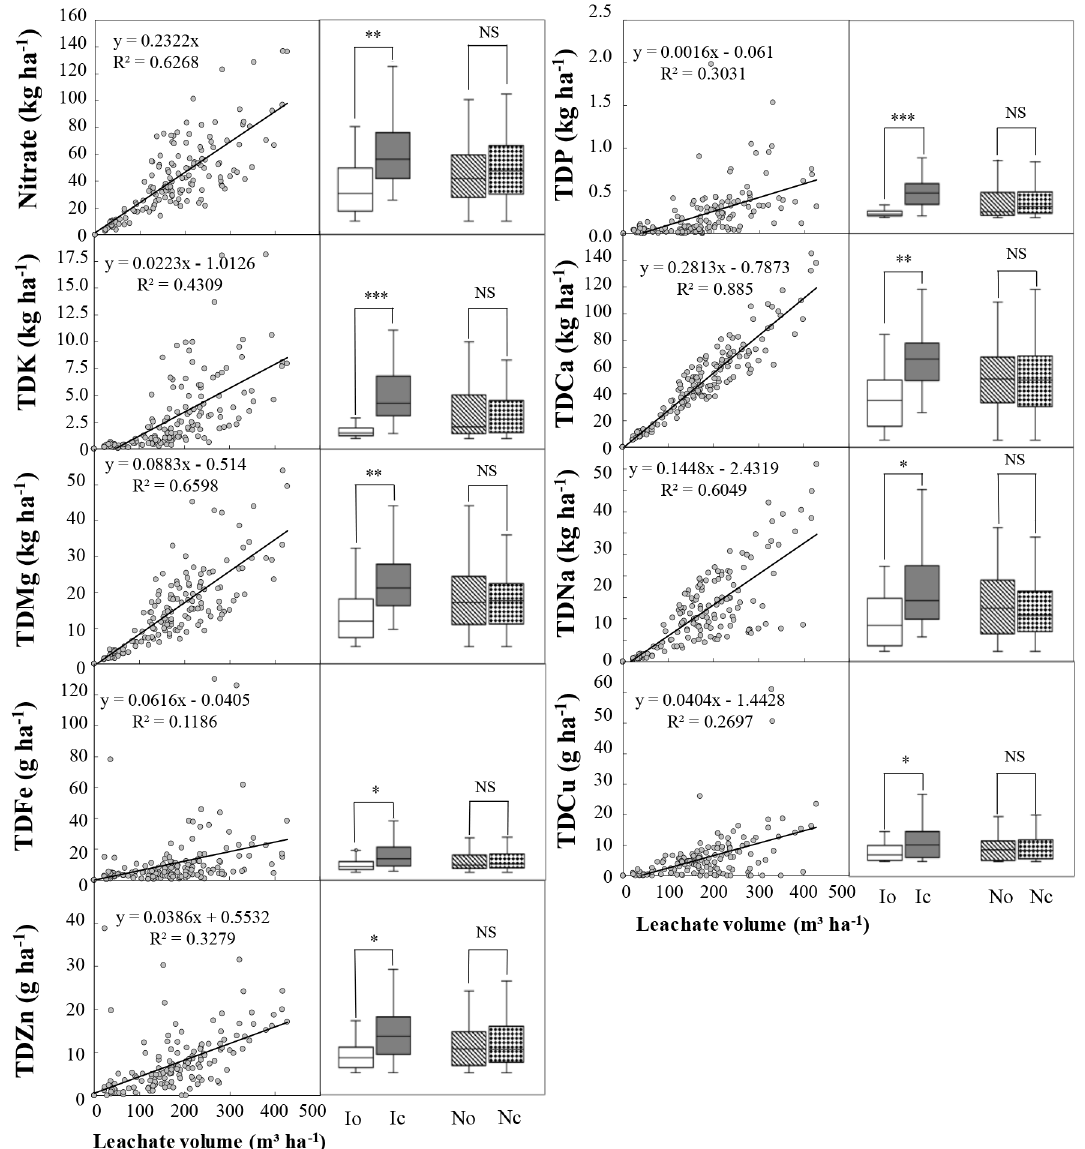
Fig 7. Relationships between the leachate volume and cumulative leached amounts of nitrate and total dissolved (TD) mineral elements in leaching water (n = 156). Treatments codes are the same as in Table 1. (cid:3) P < 0.05; (cid:3)(cid:3) P < 0.01; (cid:3)(cid:3)(cid:3) P < 0.001; NS: not